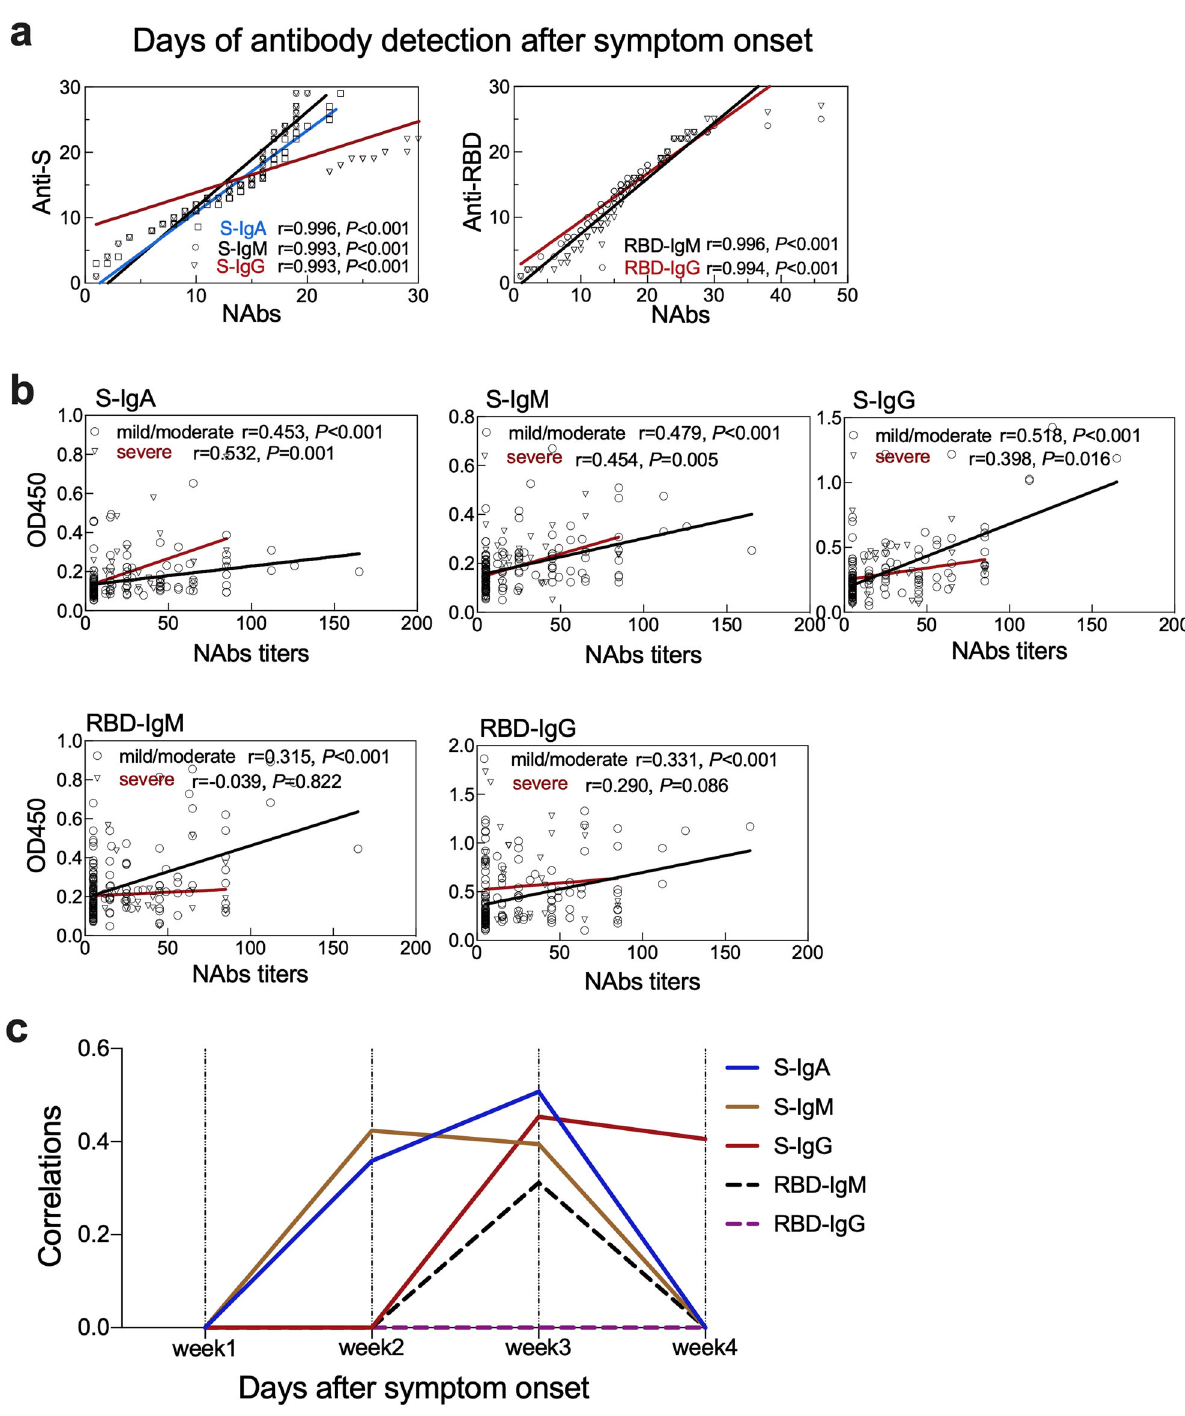
Fig. 3 Correlations of binding antibodies with neutralizing antibodies (NAbs) in mild/moderate and severe patients. a The correlations of appearance time between antibodies against spike (S) and receptor-binding domain (RBD) proteins with NAbs. The x -and y -axis are the number of days when the antibody was detected after symptom onset. b Associations of anti-S and anti-RBD antibodies levels expressed as optical density (OD) value with NAbs titers in the mild/moderate and severe patients. c The correlations of NAbs titers with the antibodies against S and RBD proteins during the disease